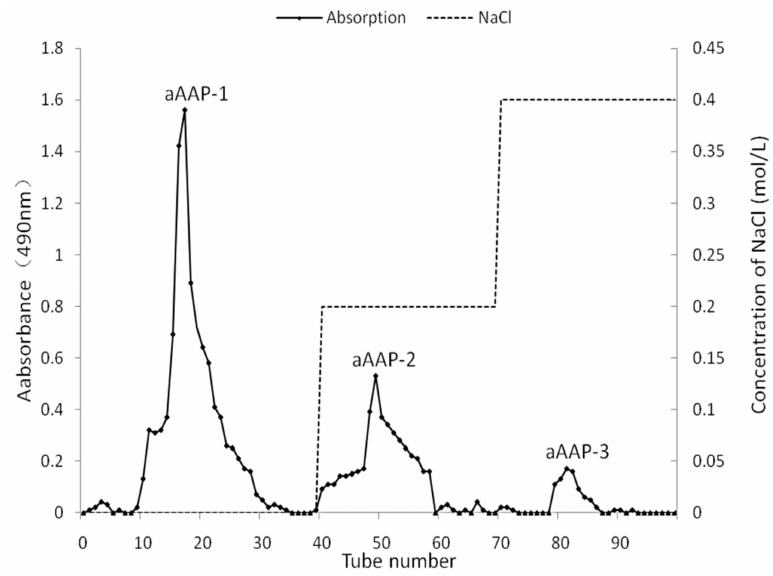
Figure 4. Chromatograms of aAAP-1 separated from cAAPon DEAE Purose 6 Fast Flow.